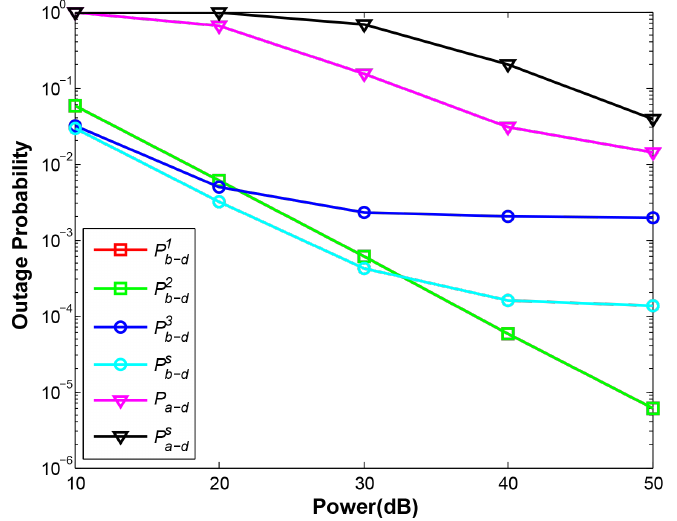
Figure 11. OP vs. total transmitting